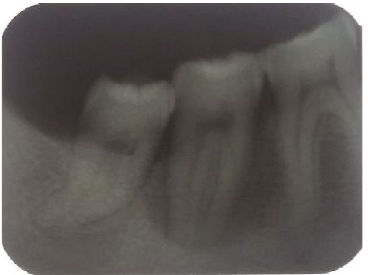
Figure 6: Periapical radiograph 10 days postoperatively; satisfactory radiological aspect with complete tumor